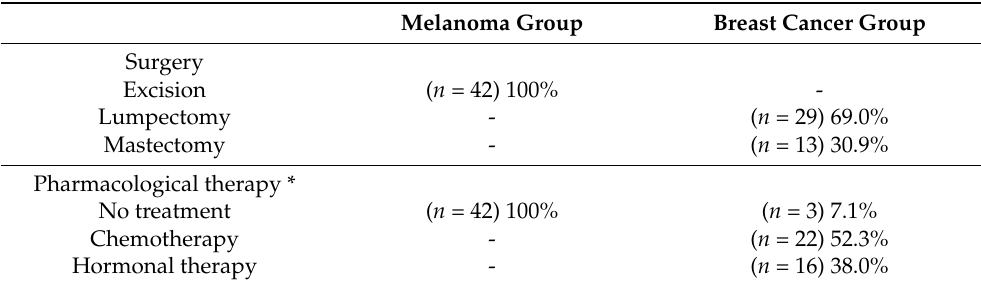
Table 2. Clinical treatments for patients with breast cancer and